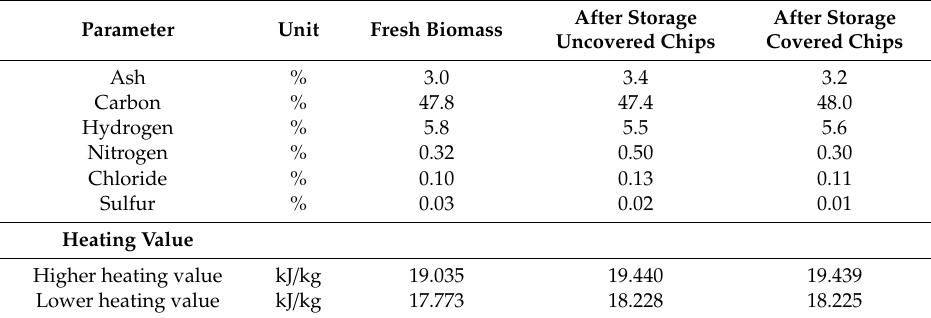
Table 3. Ash content, elementary compounds and fuel quality parameters of P16 woodchips.